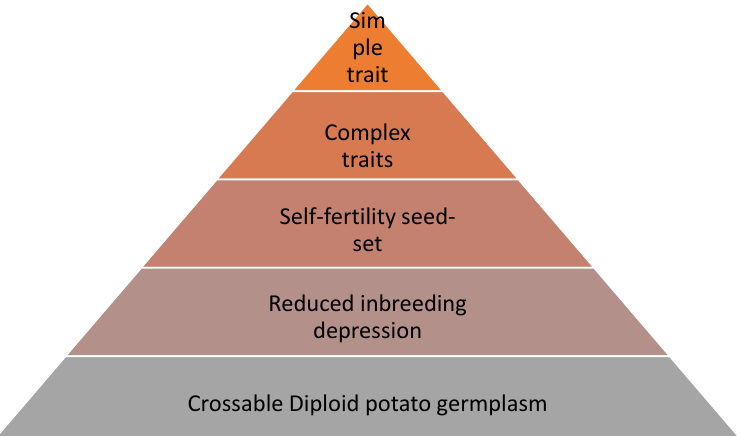
Figure 2. Schematic built-up of traits to be selected for subsequently in a diploid breeding program. The first pre-requisite is to have crossable diploid germplasm, then select for reduced inbreeding depression, then for seed-set to obtain large seed numbers, subsequently enrich the pool for positive alleles for complex traits, such as yield, and ultimately add simple traits through marker assisted selection.